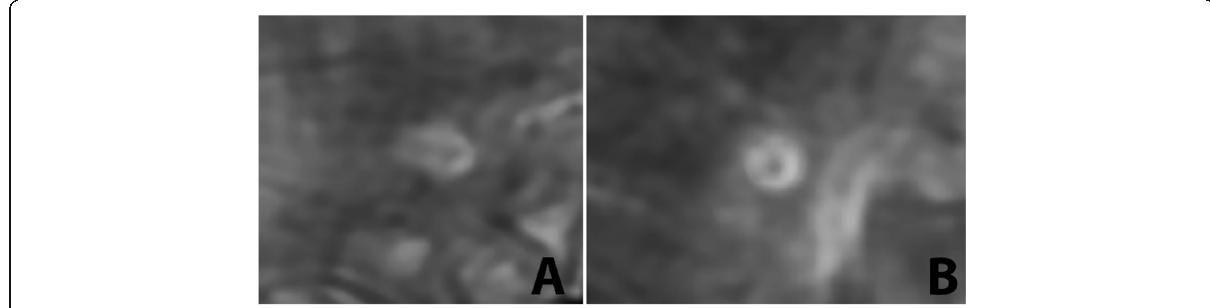
Fig. 1 Magnified SWI images showing the morphology of the central vein sign according to vein direction. a Lesion with “ coffee bean ” appearance in which a thin hypointense line (representing the CVS) is seen running through the lesion and intersecting it. b Lesion with “ doughnut ” appearance, in which a hypointense central circular dot is noted and representing the